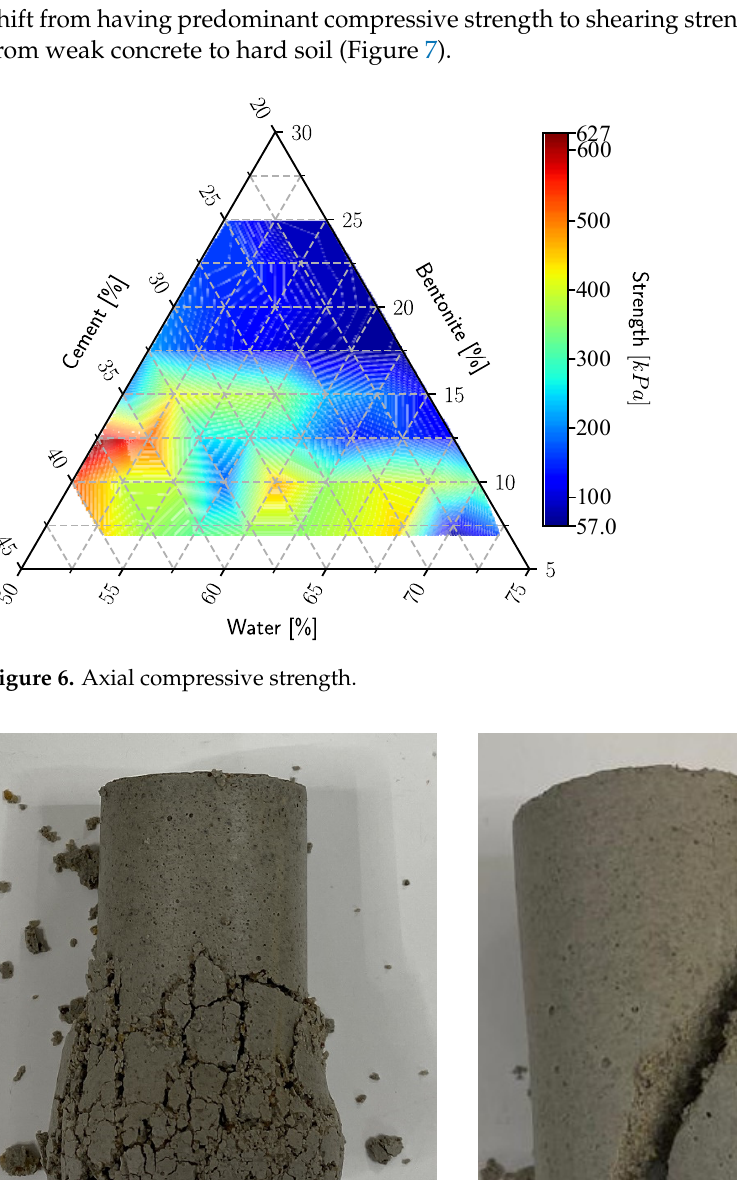
Figure 8. Permeability. All data resulting from laboratory tests are given in Table 3. The mixtures are given both in terms of percentage of each component and as classical ratios.